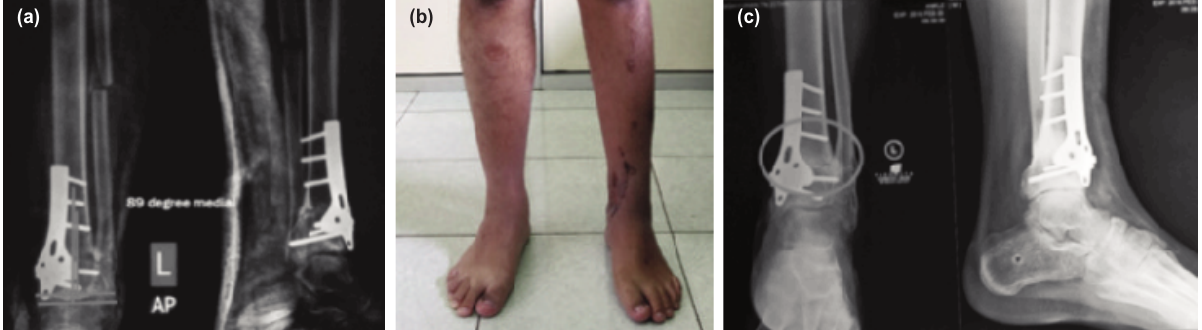
Post-operative follow-up (a) Post-operative imaging of left ankle with TAS angle of 89 o . (b) Four weeks post-operative clinical Fig. 3: condition, varus deformity is corrected. (c) Four months post-operative evaluation showed graft fusion and normal TAS angle (internal